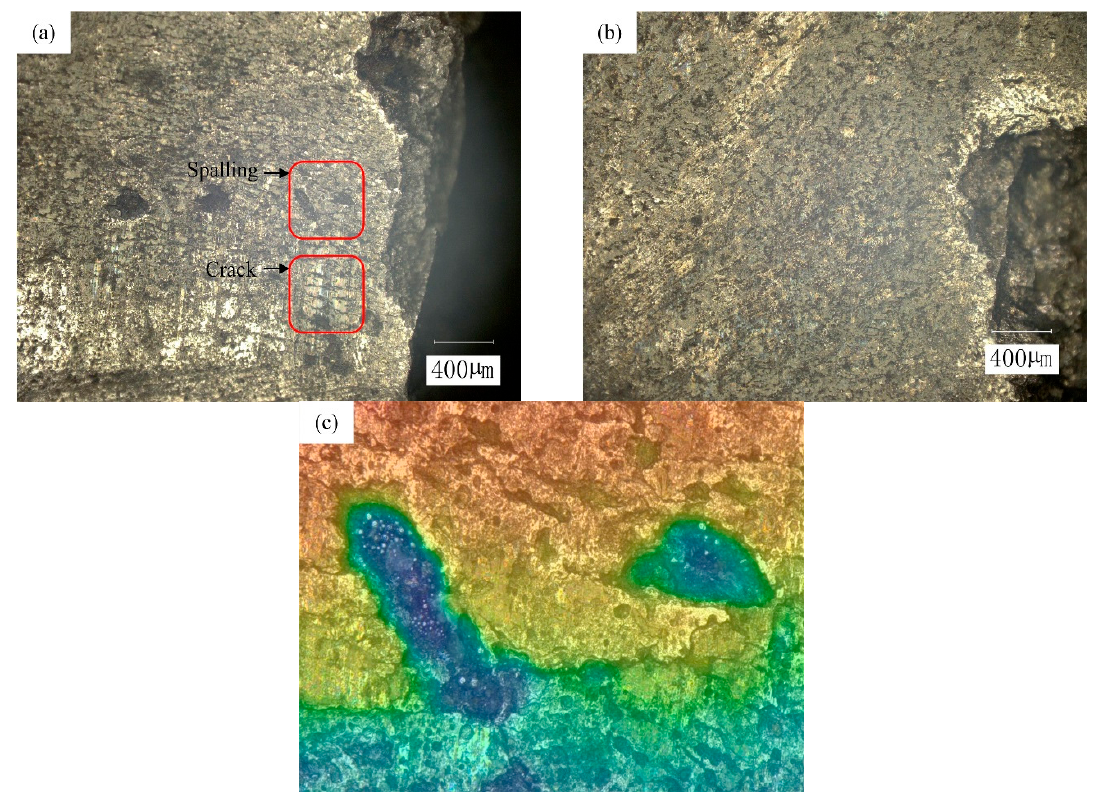
Figure 10. Morphology of the zone near spalling on gear 3-2 tooth flank: ( a ) point (V8, H8), ( b ) point (V7, H5), and ( c ) the three-dimensional (3D) morphology of the spalling zone in ( a ) (the purple represents the deeper zone, and the red represents the shallower zone).